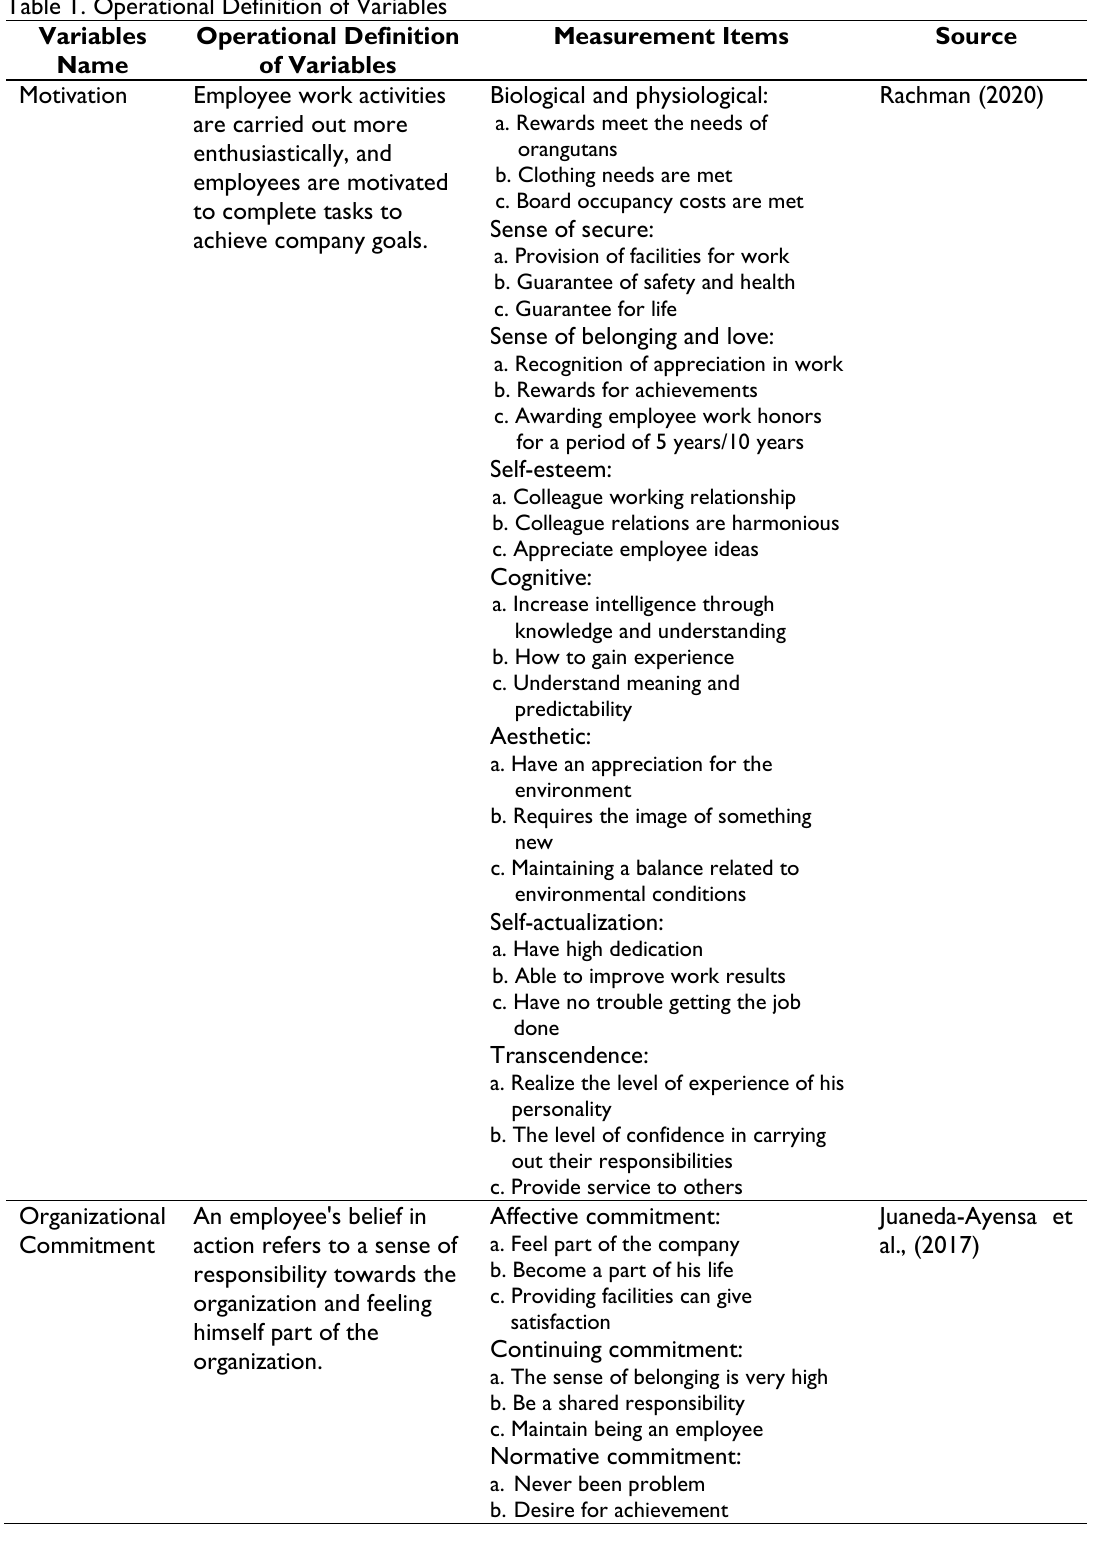
Table 1. Operational Definition of